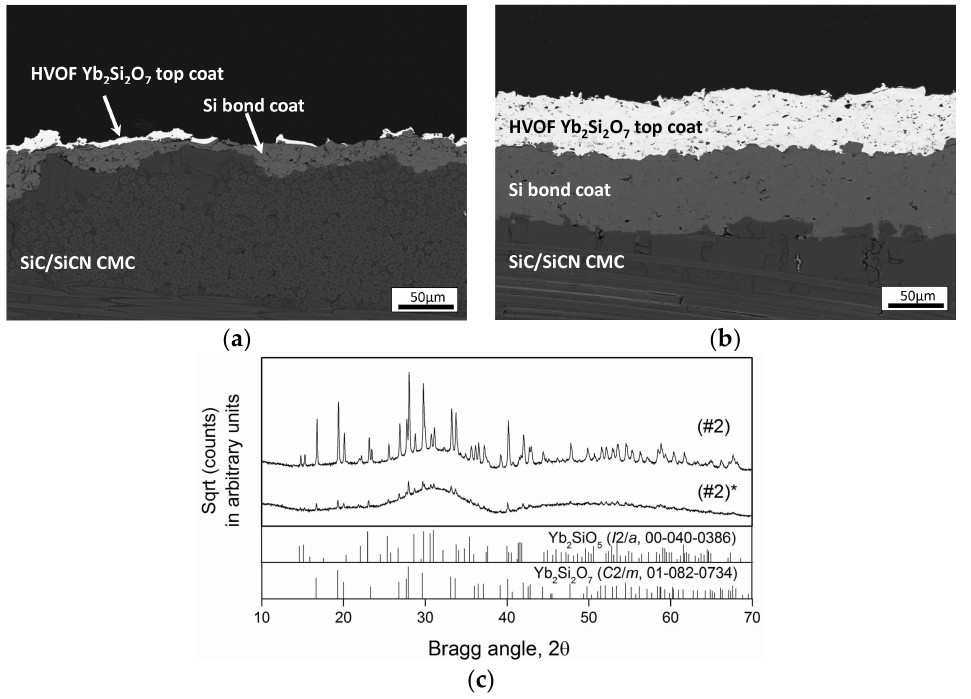
Figure 8. ( a , b ) Backscattered SEM micrographs of EBC cross ‐ sections. ( a ) HVOF sprayed Yb 2 Si 2 O 7 (#2) on Si bond coat; ( b ) HVOF sprayed Yb 2 Si 2 O 7 (#2) using reduced particle size ( d 10 = 17 μ m, d 50 = 25 μ m, d 90 = 34 μ m) on Si bond coat. ( c ) Comparison of the XRD patterns of the Yb 2 Si 2 O 7 coatings deposited using same spray parameters (#2) but different particle sizes. (#2) and (#2) * denote original and reduced particle sizes, respectively.